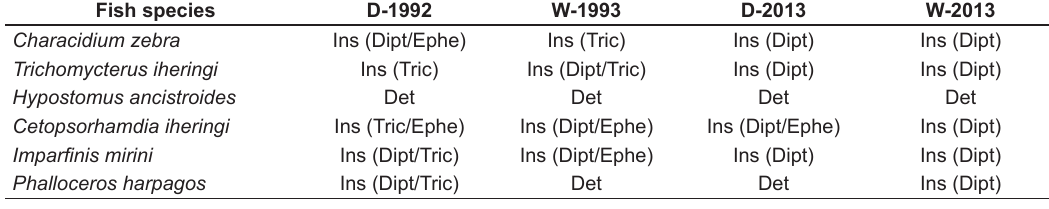
Table 4. Food habit of the fish species sampled in the Capivara River, during the dry (D) and wet (W) season of 1992, 1993 and 2013. Ins-insectivorous, Det-detritivorous. Predominant Hexapoda orders consumed by the insectivorous species: Dipt-Diptera, Ephe-Ephemeroptera and Tric-Trichoptera.